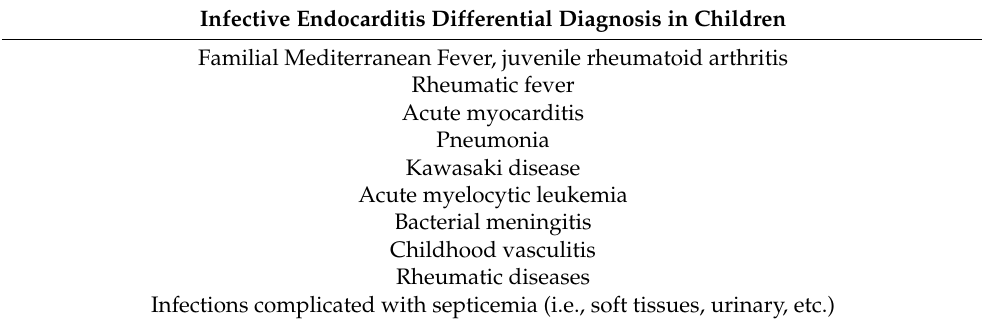
Table 4. Differential diagnoses of infective endocarditis in